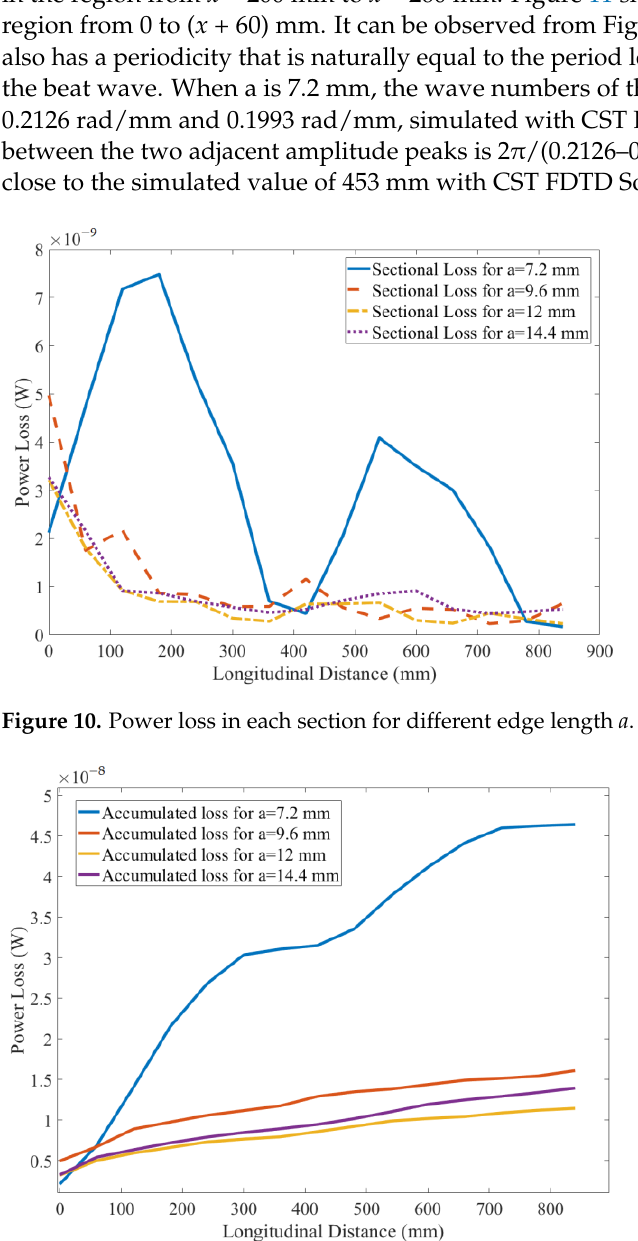
Figure 11. Accumulated power lossin the section from 0 mm to different longitudinal distances for different edge length a .